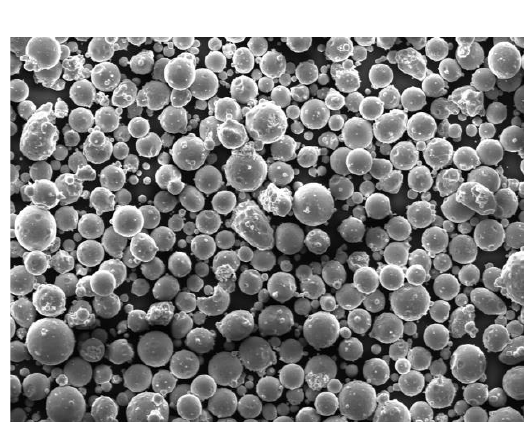
Table 1. Chemical composition of the powder used to fabricate the TPMS lattices (SS316L). Element C Si Mn Cr Ni Fe Wt. %